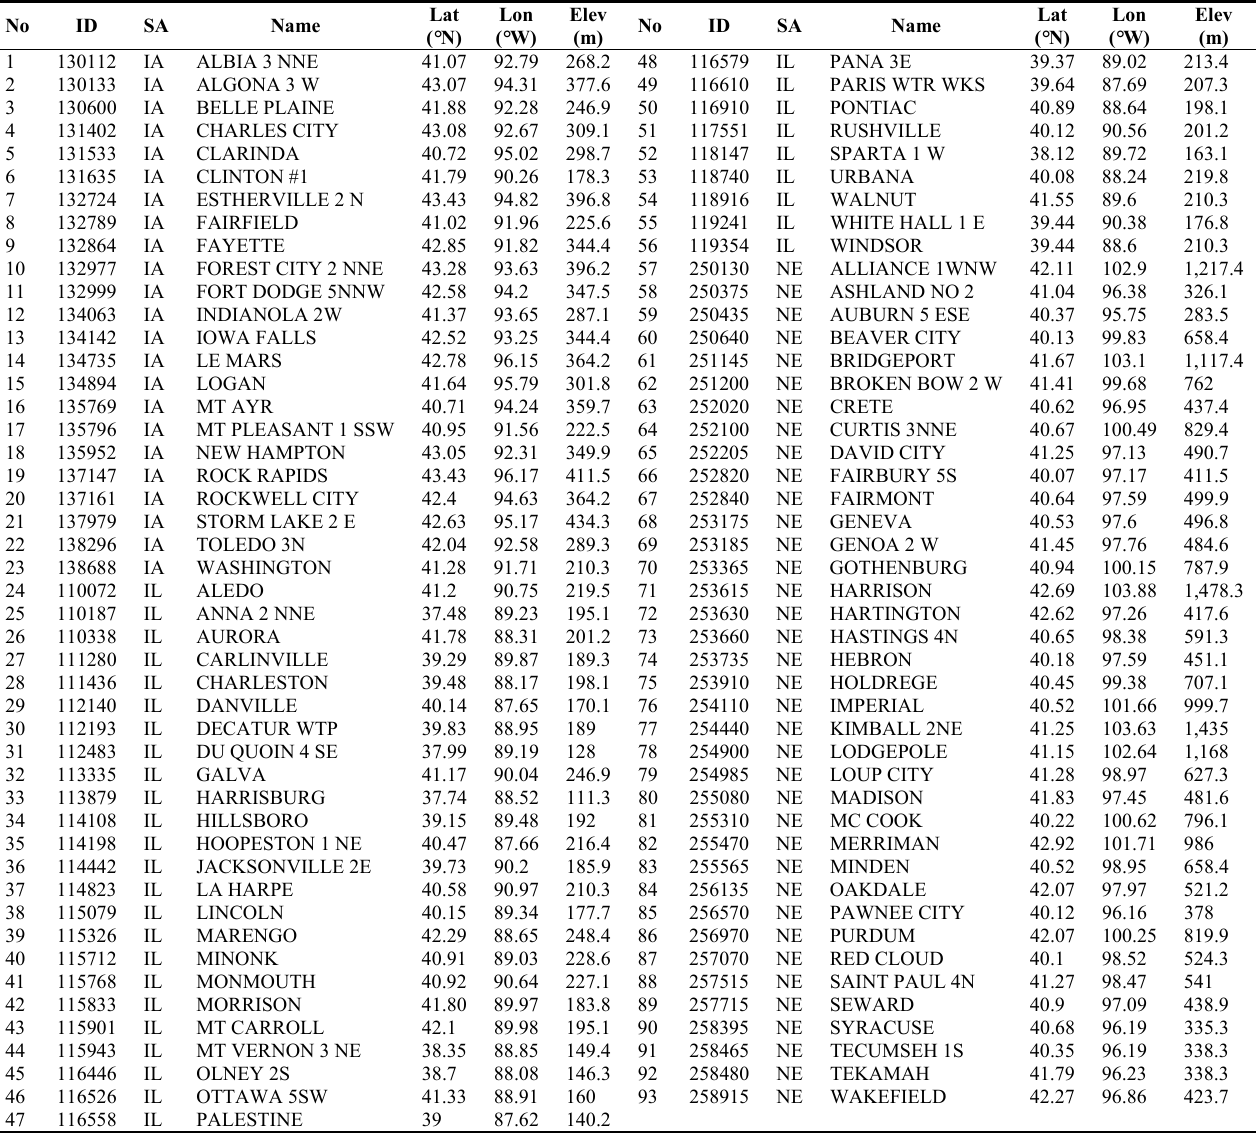
Table A1. Basic information of selected meteorological stations. Meteorological data include ID, name, and the geographic coordinate ( i.e. , latitude, longitude, and elevation) of each station. SA means US state